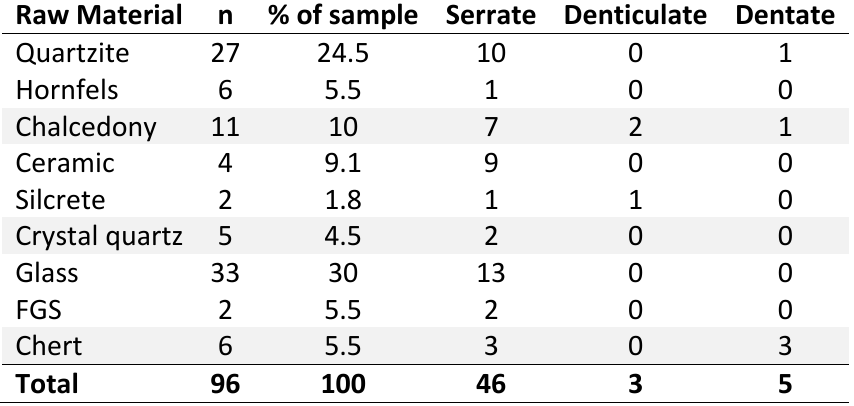
Table 7. Raw material type and marginal projection type for bifaces with marginal projections. Abbreviations: Fine grained sedimentary